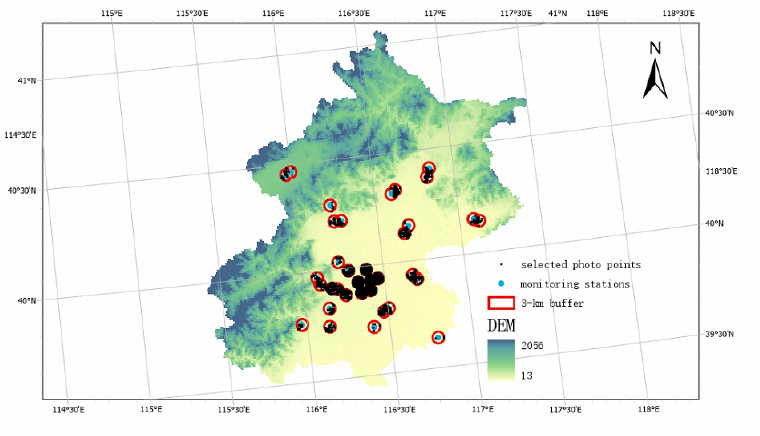
Figure 4. Three-kilometer buffers around monitoring stations and the locations at which smartphone photographs were